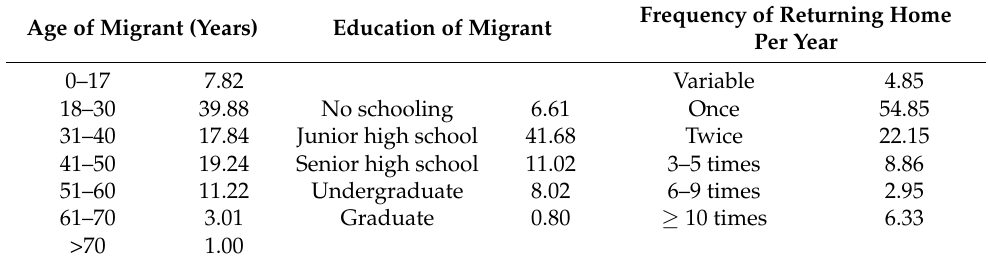
Table 4. Migration characteristics